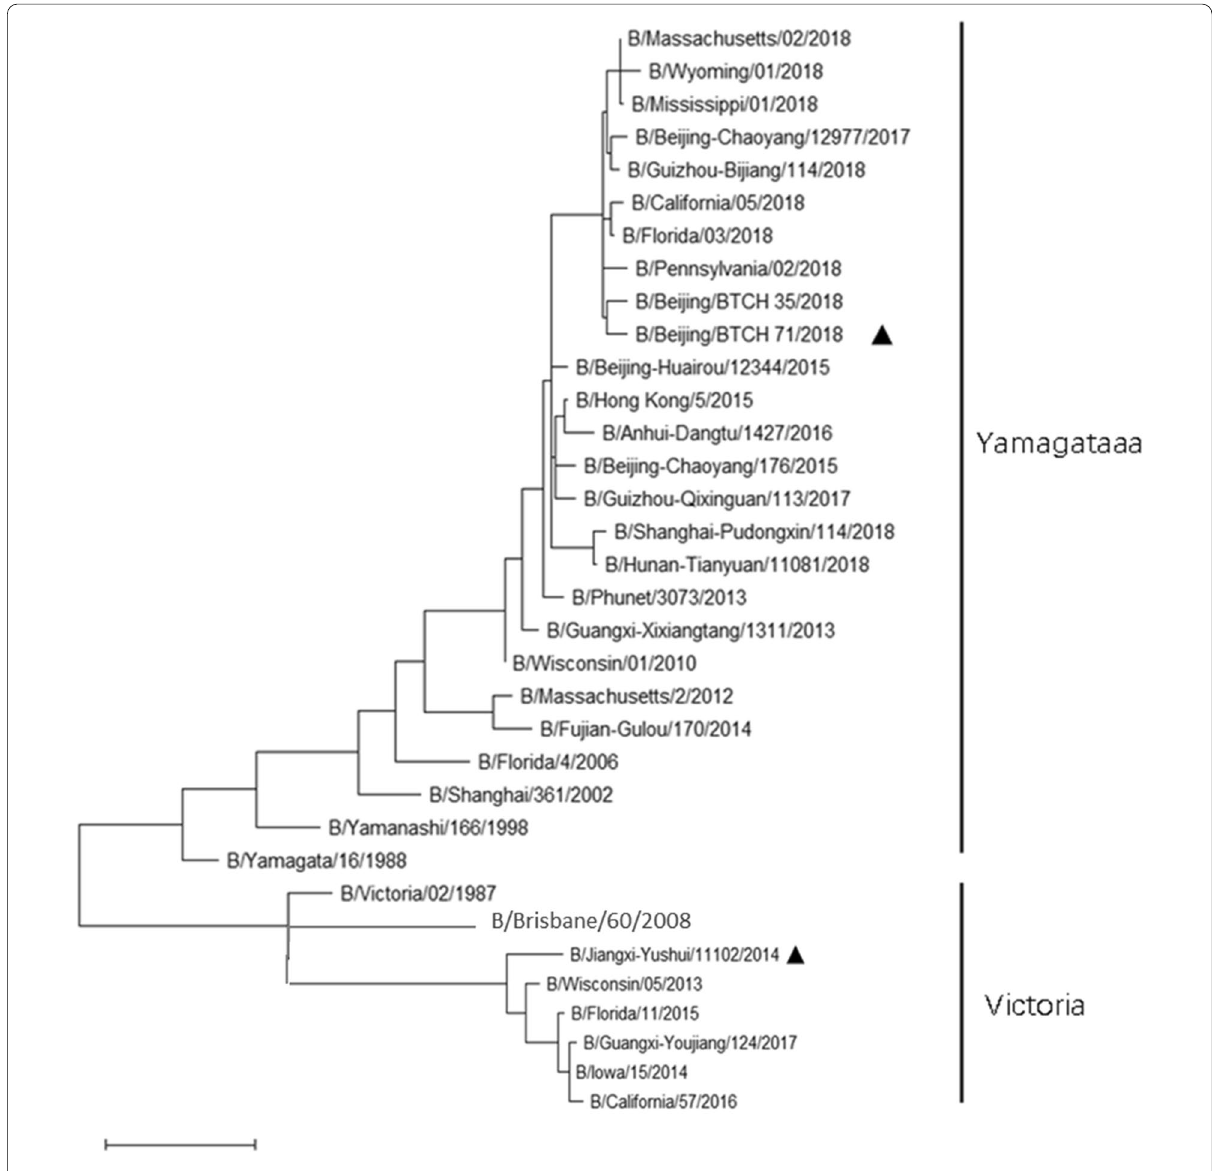
Fig. 1 Phylogenetic tree of the HA gene of type B influenza viruses used in the study. Phylogenic tree was constructed using the partial HA genes (370-610NT covering the most important positions distinguishing the Victoria and Yamagata lineages) from the clinic isolates and full-length HA sequences from the GenBank as well as GISAID. Strains labeled with black triangle represented as B/Victoria and B/Yamagata lineage viruses were used as antigens in the present